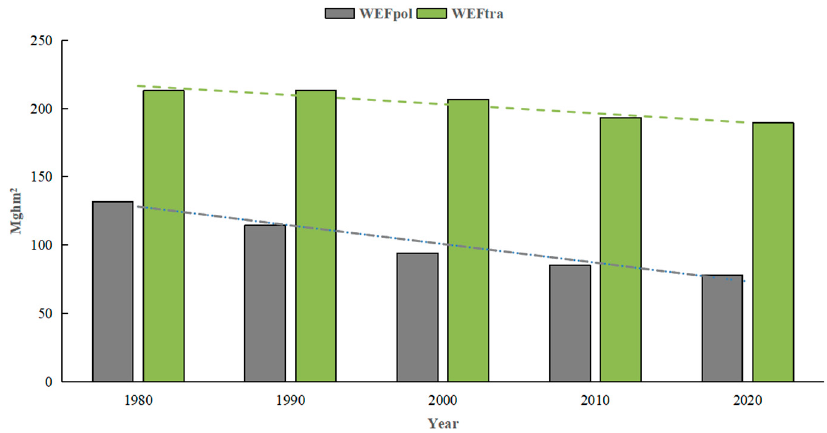
Figure 2. Transition of the total WEF in Japan during 1980–2020.